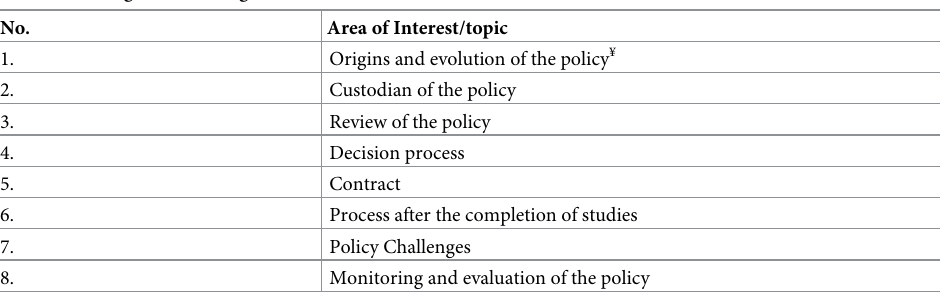
Table 1. Abridged interview